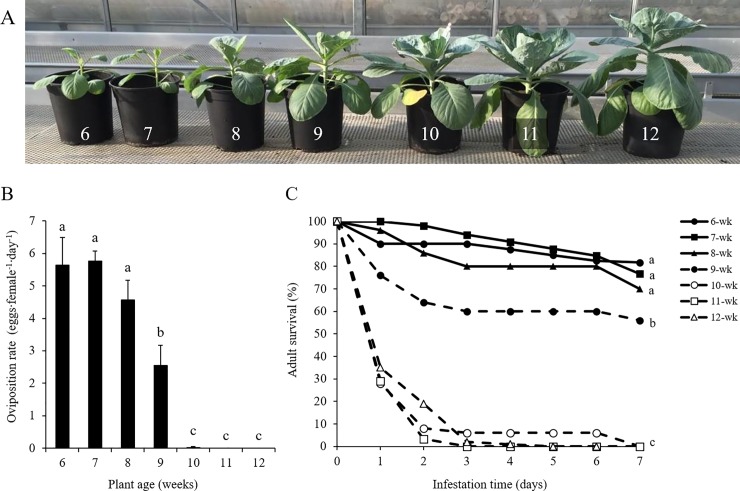
Performance of Aleyrodes proletella on Brassica oleracea cv. Rivera of different ages.(A) Appearance of plants used for the experiment, ranging from 6- to 12-weeks-old. Plant ages are indicated with numbers on the pots. (B) Oviposition rate (eggs·female-1·day-1; mean + SE) and (C) daily survival (%) of whitefly females on leaves of the different plant ages. Values represent means of 5 plants per age (2 clip cages enclosing 5 females each per plant). Lines/bars marked with different letters indicate significant differences between plant ages (p < 0.05).